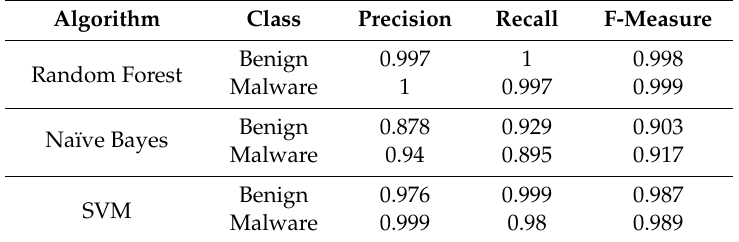
Table 9. Classification result of base samples and adversarial samples with the full feature model. Class Algorithms Benign Malware Radom Forest Base samples (Benign) Random Adversarial samples (Malware)